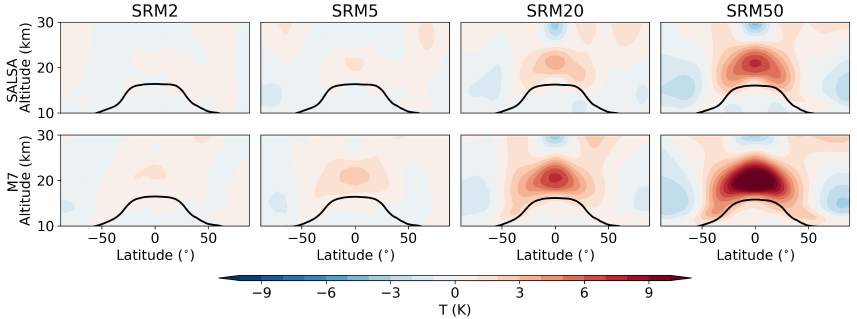
Figure 10. The temperature anomaly due to the Baseline stratospheric sulfur injection with different injection rates simulated with SALSA (upper panels) and M7 (lower panels). The black line indicates the